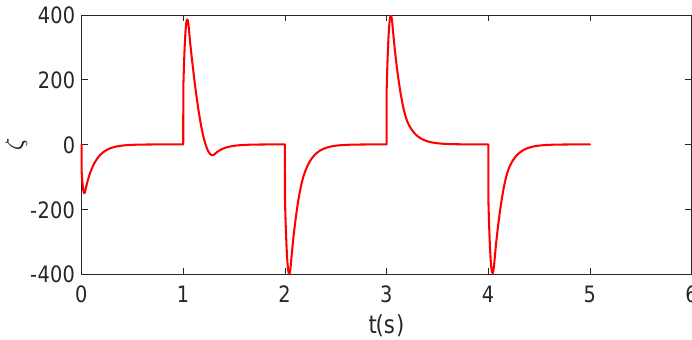
Figure 11. State of the anti-windup compensator.